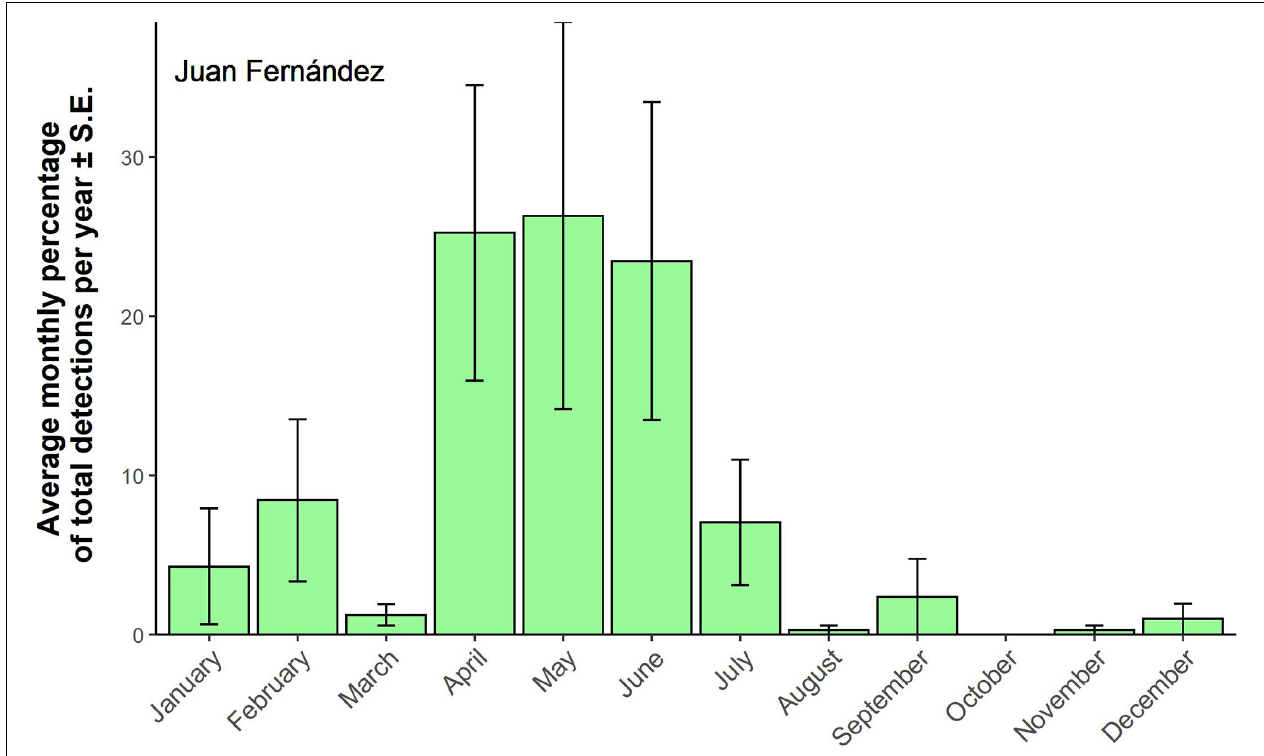
FIGURE 5 | Chilean blue whale detections at Juan Fernández. Averaged monthly detections ± SE. Monthly detections have been standardized by calculating the monthly percentage of total detections per year. Monthly detections were averaged over 10 years of available data.